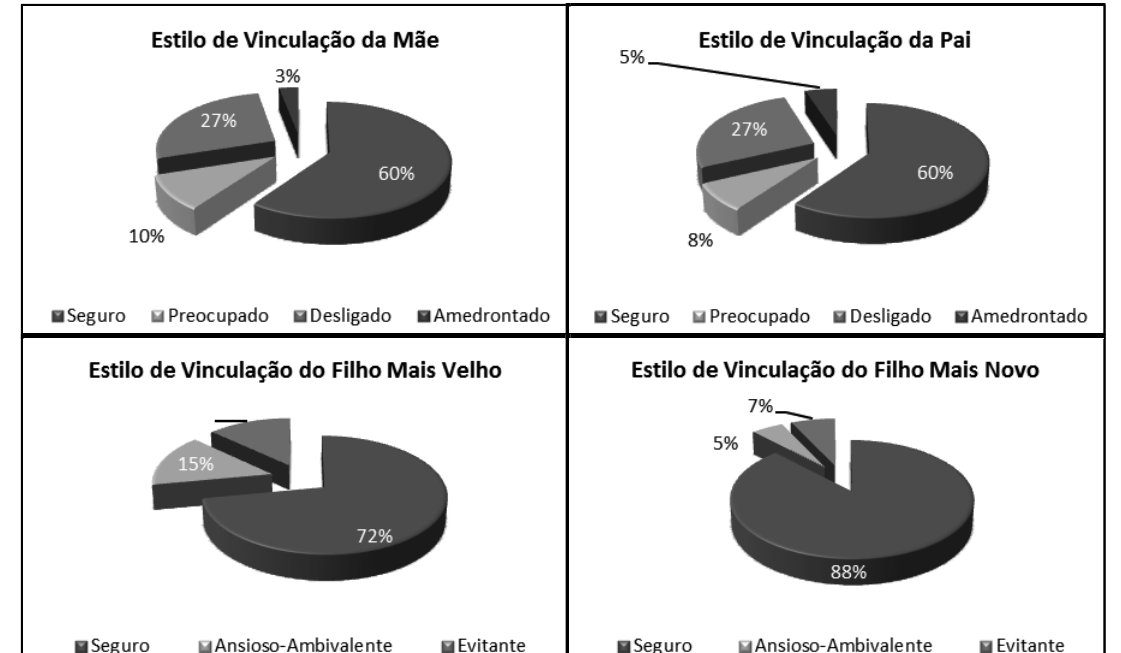
Figura 1. Descrição dos estilos de vinculação dos membros da